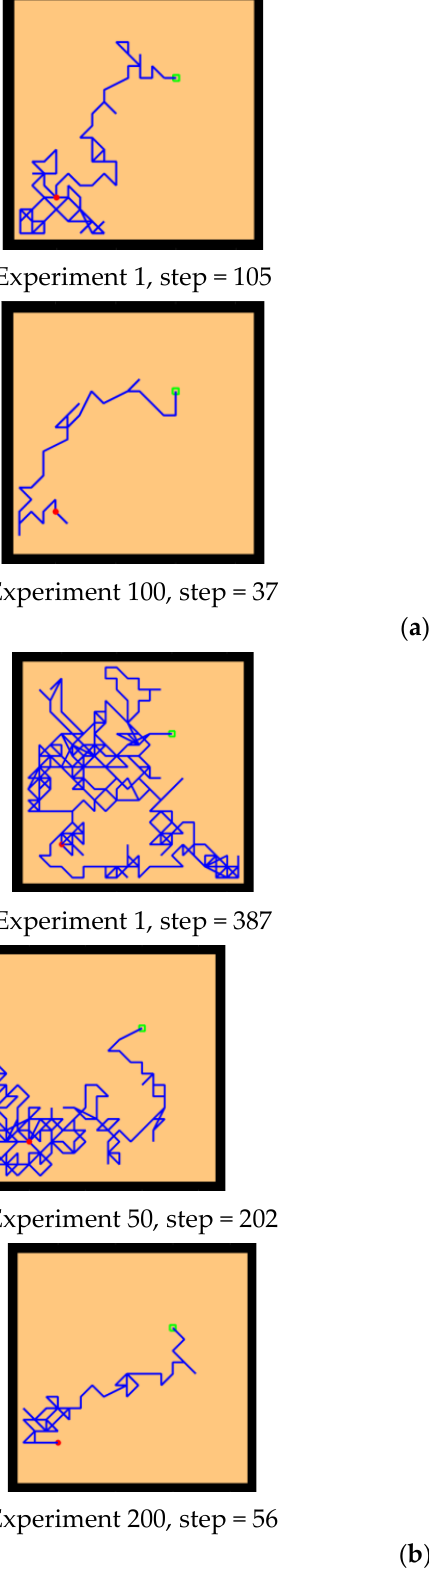
Figure 14. Comparative experiment of the Q-learning model and our model in the water maze. ( a ) Our model. ( b ) Q-learning model.